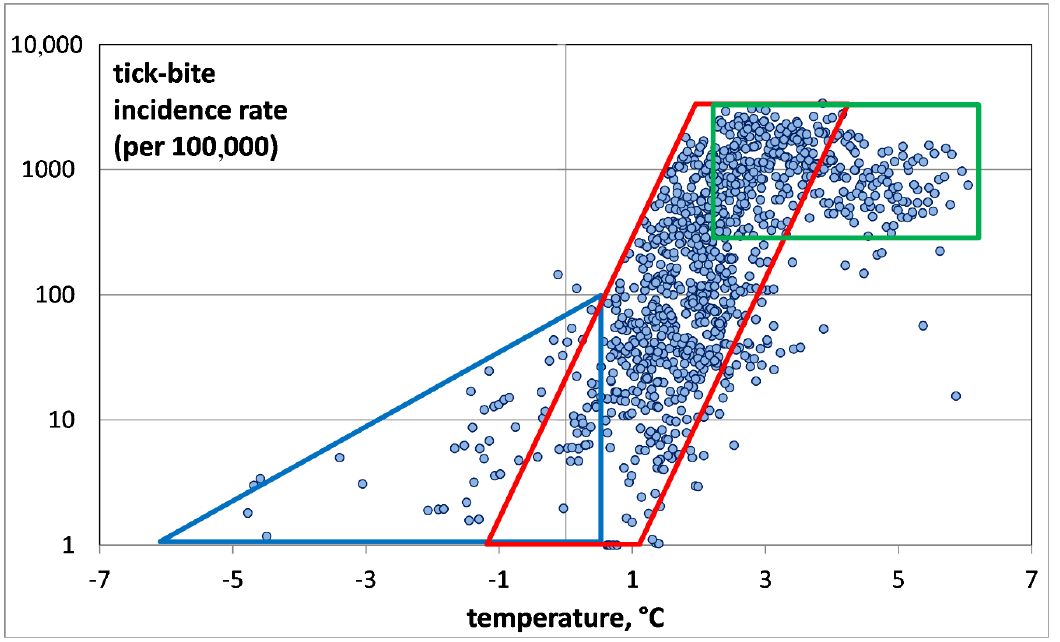
Figure 4. Nonzero tick-bite incidence rate versus average annual model air temperature for all administrative units of the Arkhangelsk Oblast, Karelia and Komi. The highlighted areas are represented as the invasion zone (blue color), the exponential growth zone (red) and the saturation zone (green).